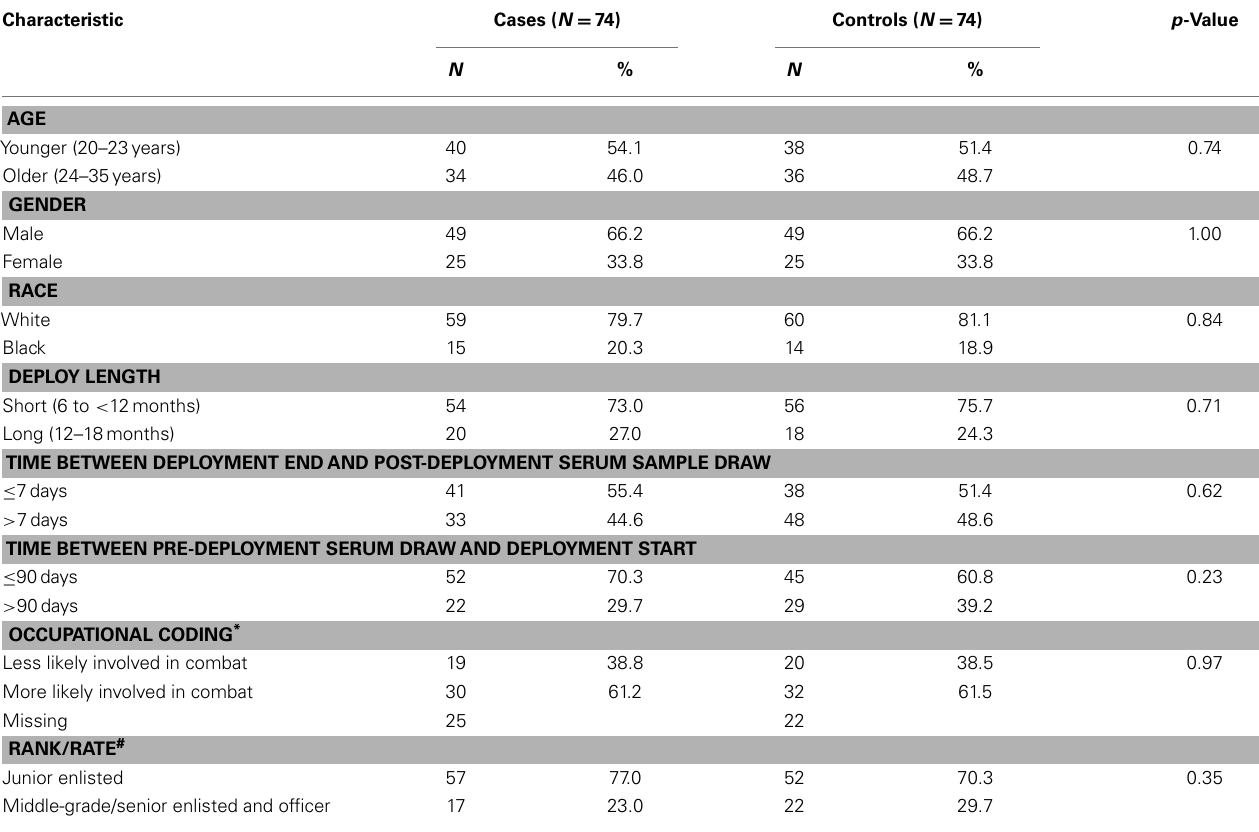
Table 1 | Baseline characteristics of